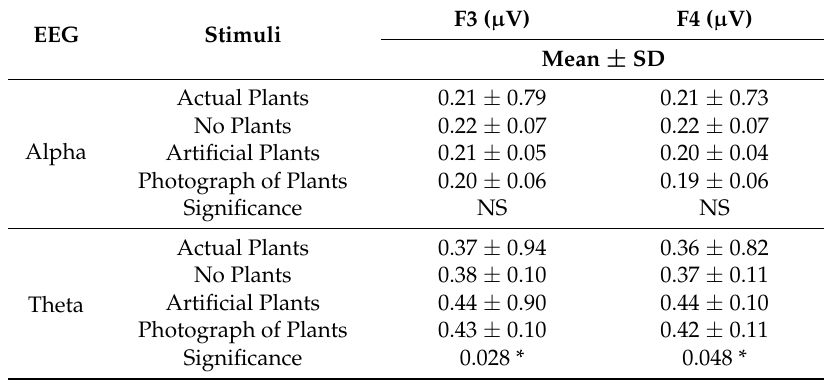
Table 2. Electroencephalography (EEG) results (alpha and theta waves) following visual